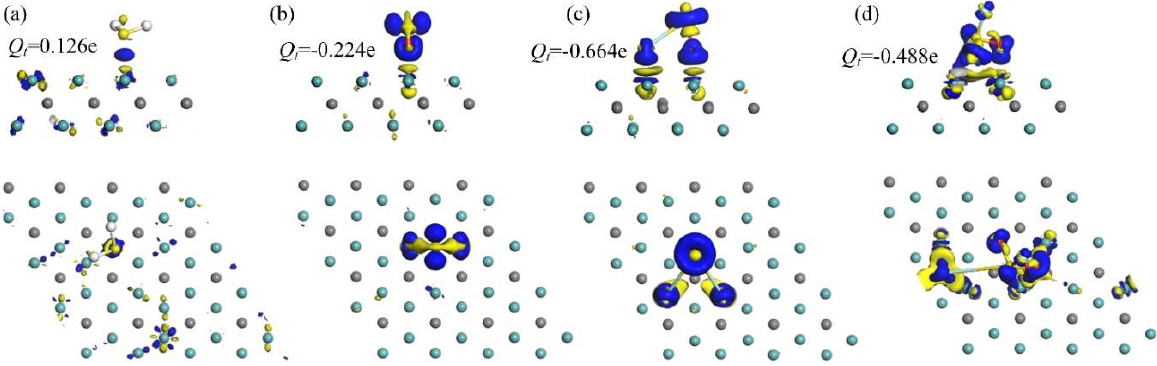
Figure 3. CDD of H 2 S ( a ), SO 2 ( b ), SOF 2 ( c ) and SO 2 F 2 ( d ) systems. In CDD, the blue area is electron accumulation and the yellow area is electron depletion, with an isosurface of 0.05 e/Å 3.